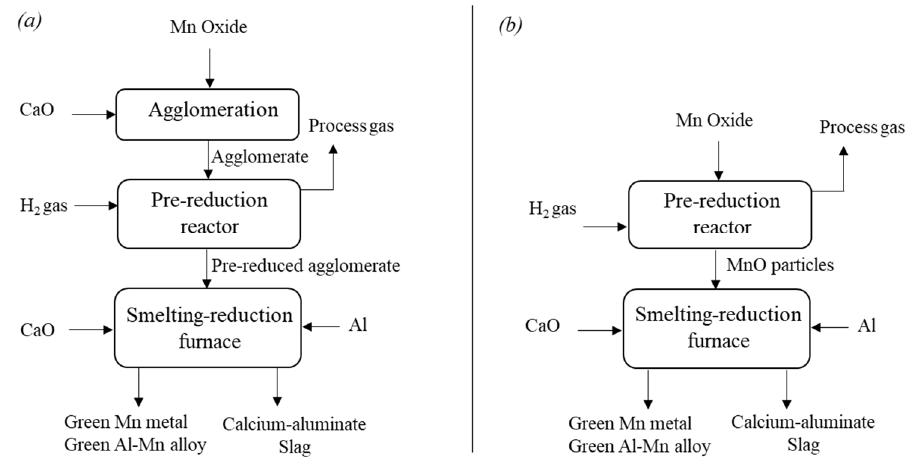
Figure 5. Material flow to produce Green Mn and AlMn alloys via HAlMan process; ( a ) with agglomeration step, and ( b ) without agglomeration step.